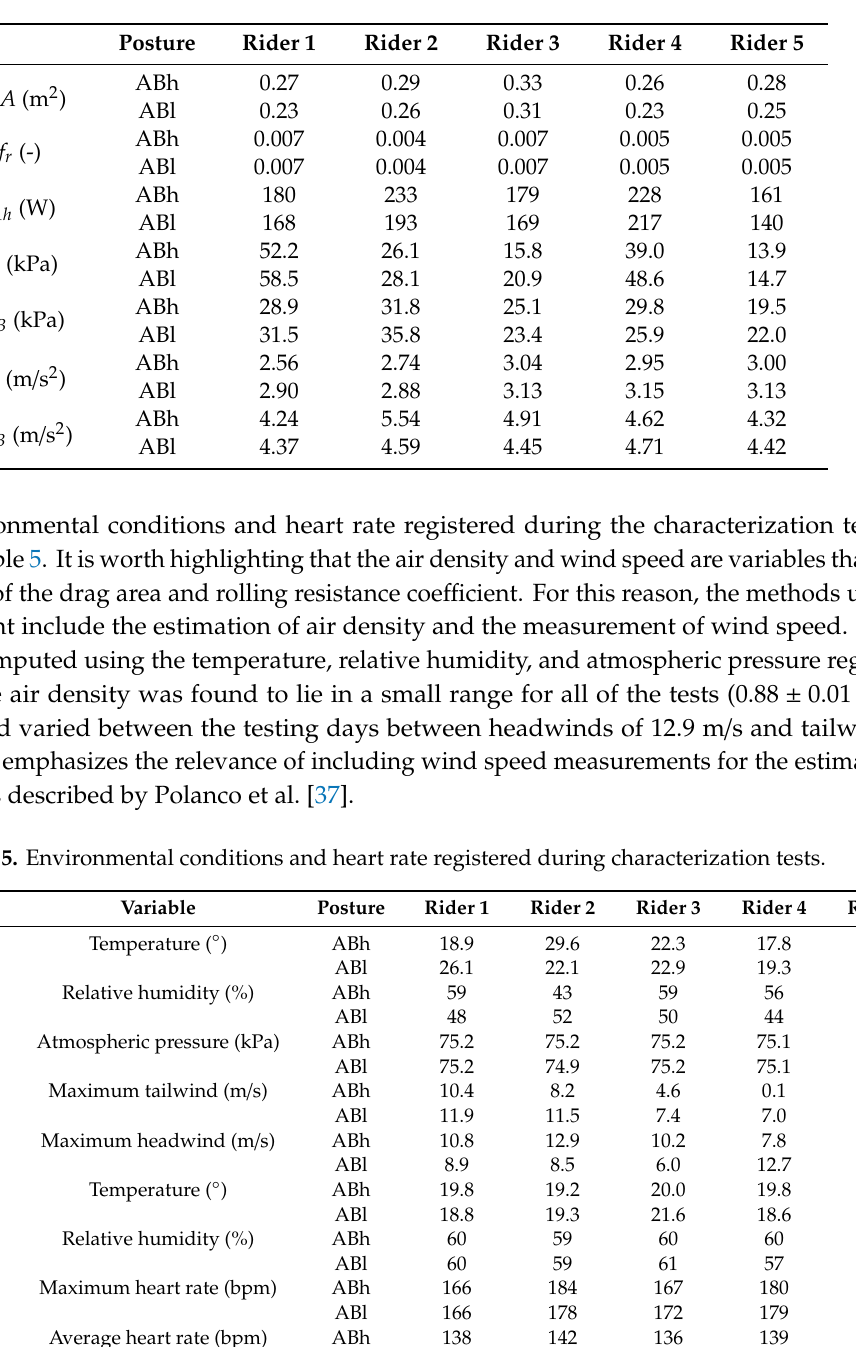
Table 4. Performance and comfort indices obtained from characterization.